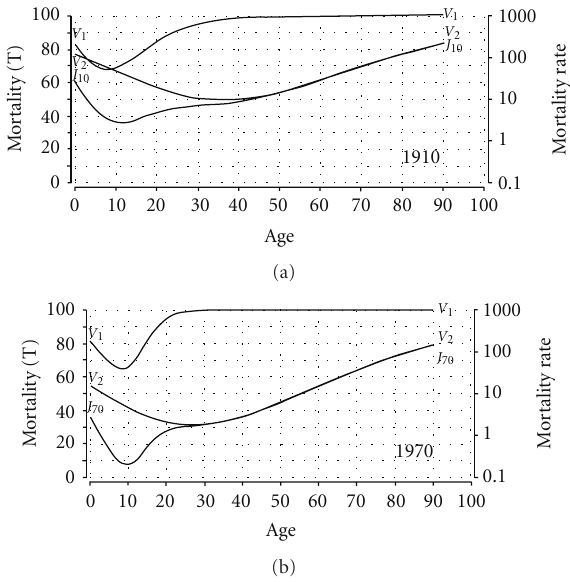
Figure 8: (a): Janus curve ( J 10 ), V 1 and V 2 curves of U.S. 1910 mortality. Bottom panel: Janus curve ( J 70 ), V 1 and V 2 curves of U.S. 1970